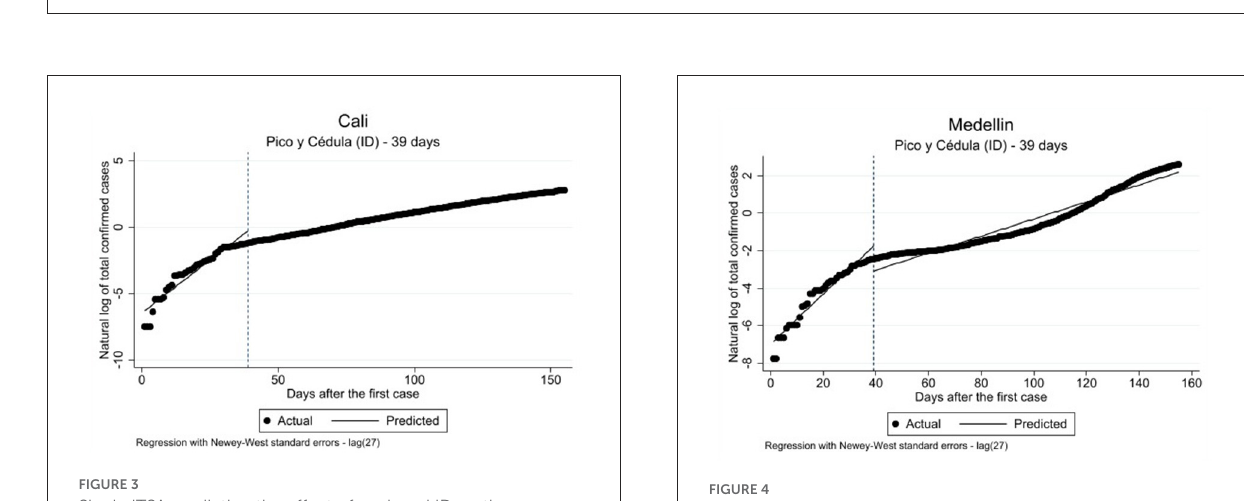
FIGURE3 Single ITSA predicting the effect of peak and ID on the COVID-19 infection rate in Cali; the interruption time-point of the analysis is 14 days after the actual implementation of the policy.